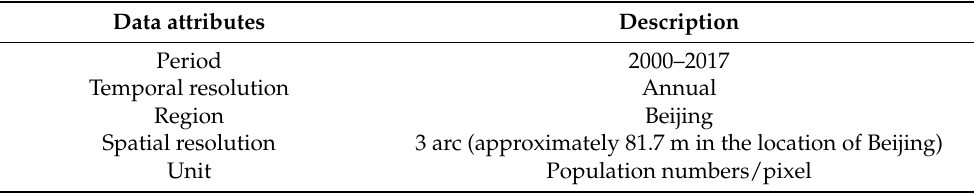
Table 3. Attributes of Population